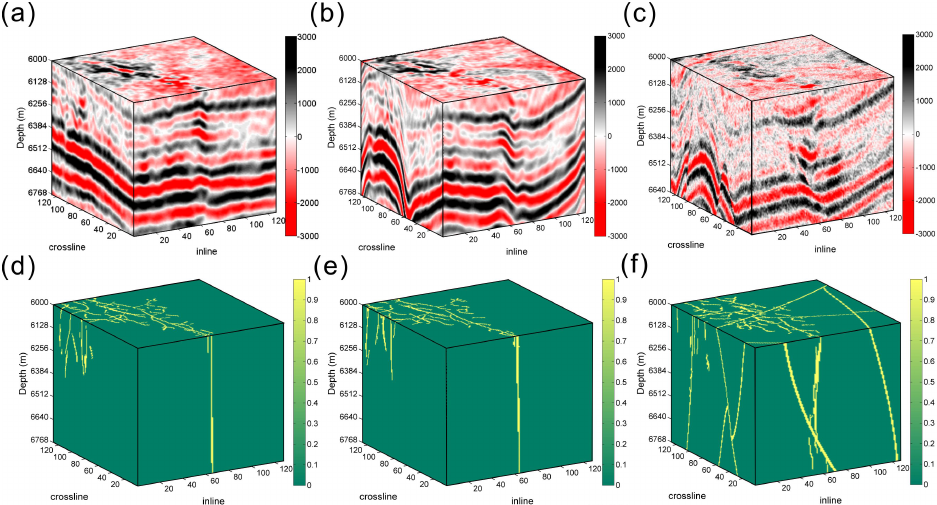
Figure 1. The workflow of structural data augmentation. ( a ) Raw 3D seismic data. ( b ) Seismic data after adding virtual folds. ( c ) Seismic data after adding virtual faults and random noise. ( d ) Manual fault interpretation label data. ( e ) Label data after adding virtual folds. ( f ) Label data after adding virtual